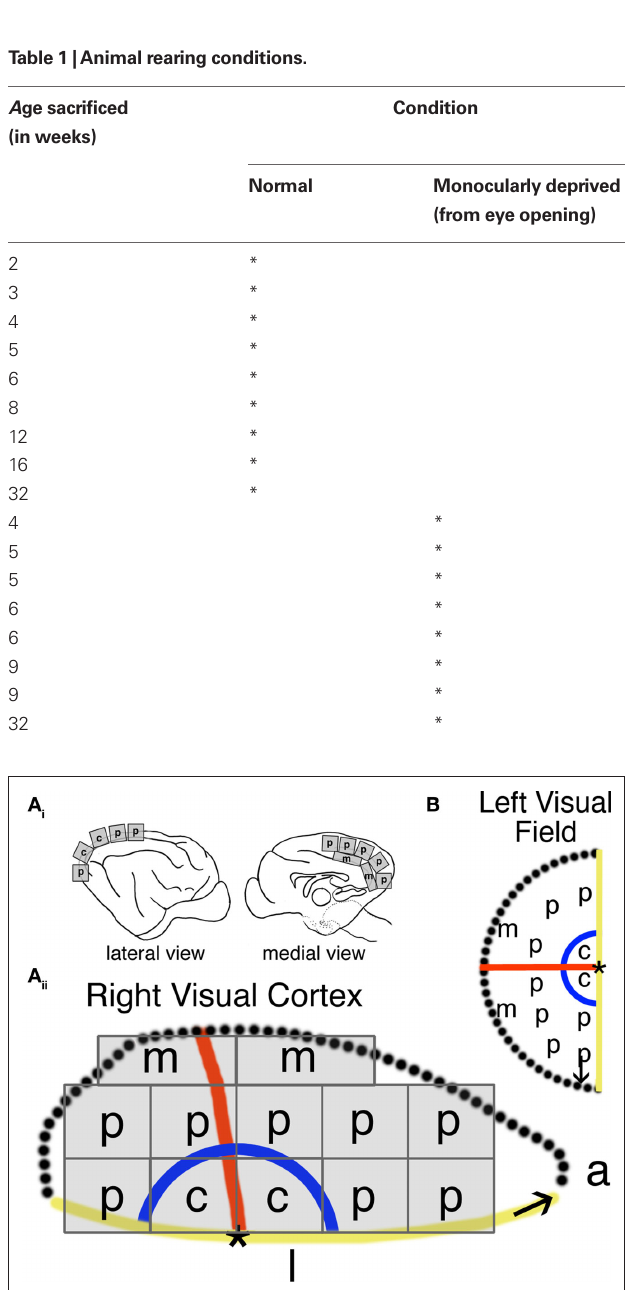
FiGure 1 | Tissue sample collection across visual cortex and corresponding visual field representation. The expression of synaptic proteins was quantified from tissue samples collected in the central (c), peripheral (p), and monocular (m) visual field representations of primary visual cortex (A -A ) . The location of visual field representation in primary visual i ii cortex was assessed using anatomical markers previously identified by Tusa et al. (1978) (B)